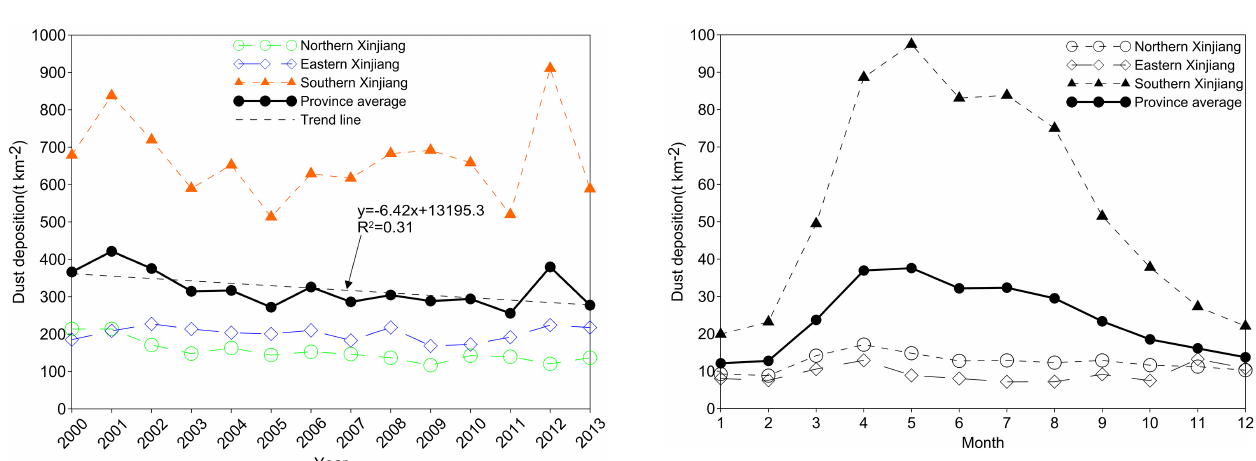
Figure 3. Annual average dust deposition in Xinjiang Province from 2000 to 2013. Dust deposition in northern, eastern and south- ern Xinjiang is the average deposition at 8, 2 and 4 stations, respec- tively.